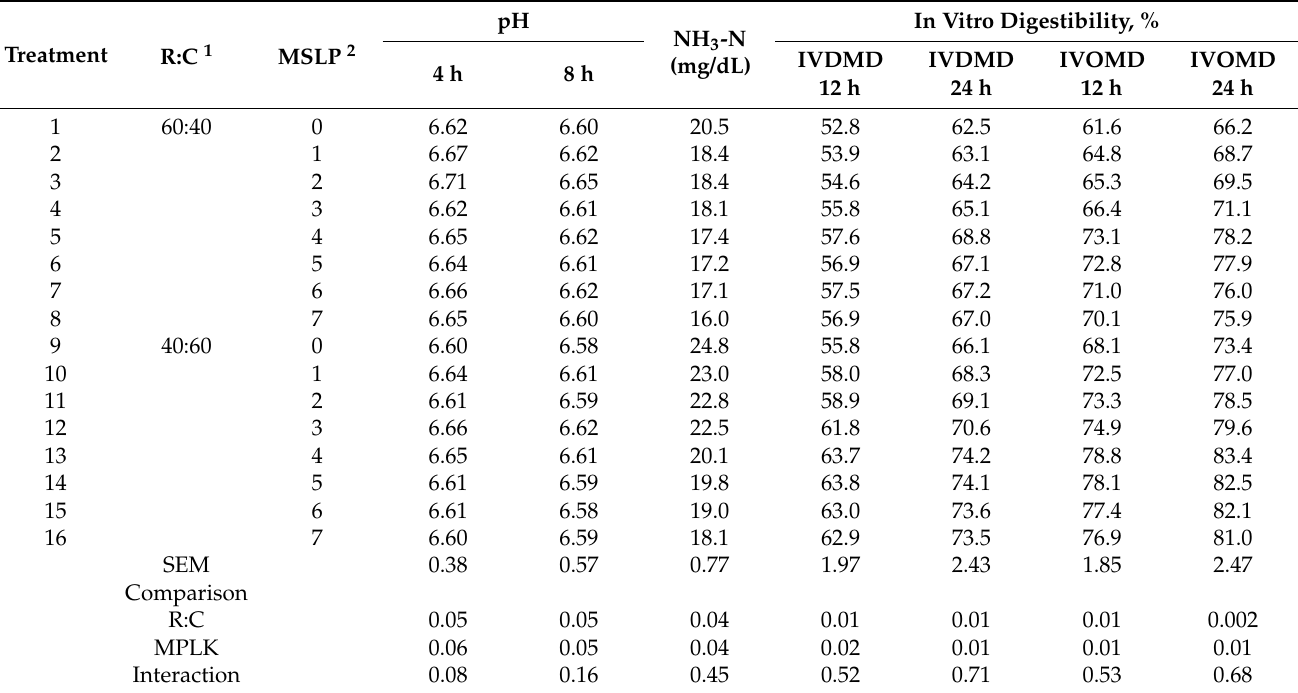
Table 3. The effect of roughage-to-concentrate (R:C) ratio with Mitragyna speciosa Korth leaves powder (MSLP) supplementation on rumen ecology and in vitro